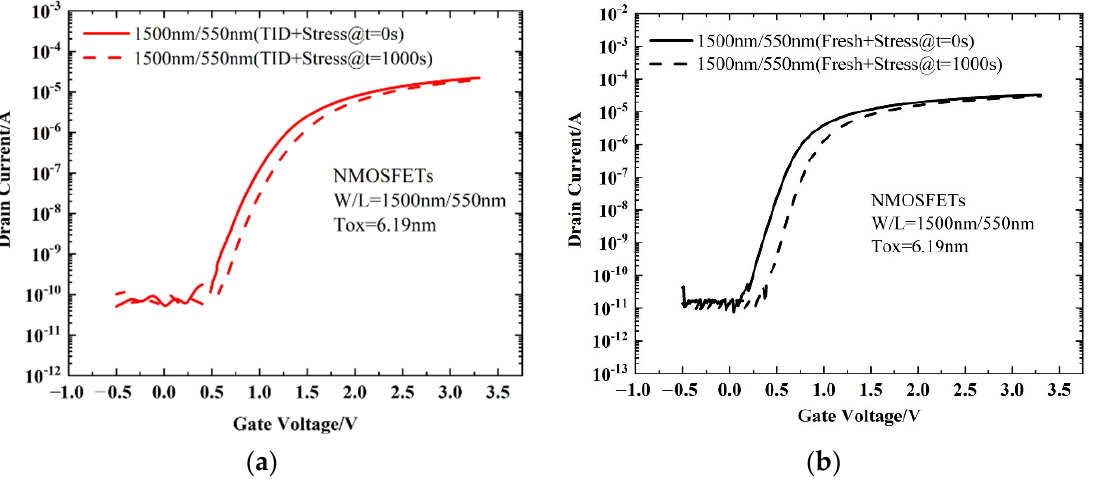
Figure 4. Drain current variations in I d –V g curves after electrical stress of ( a ) TID and ( b ) fresh devices. The W / L of the devices is 1.5 μ m/0.55 μ m.